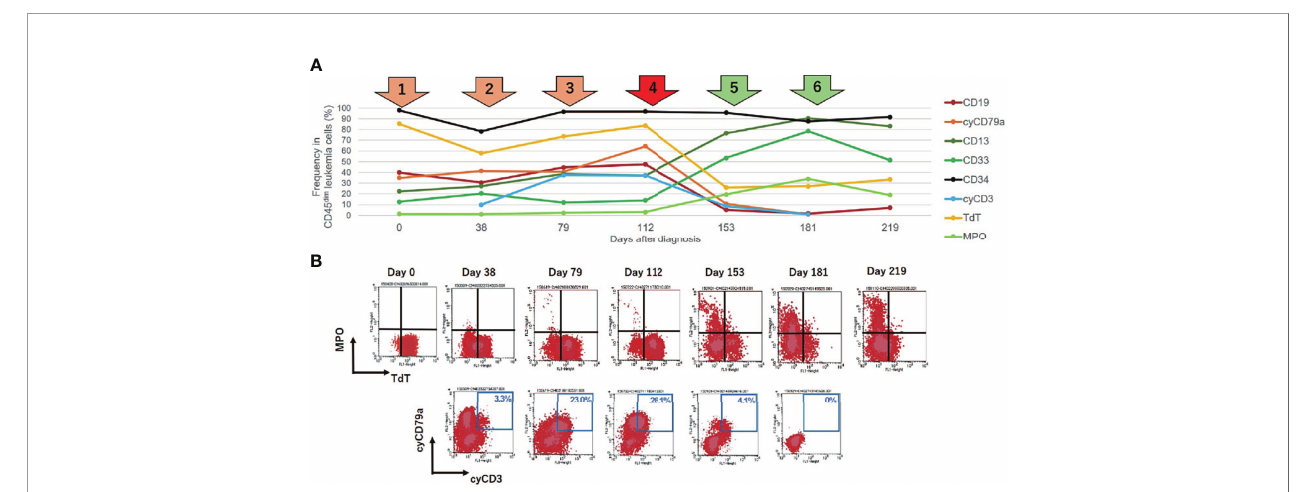
FIGURE 2 | Changes in leukemia cell immunophenotypes in the present case. Flow cytometric analysis revealed that leukemia blast cells in this case evolved immunophenotypically during sequential intensive chemotherapy. The analyzed leukemia cells were taken from bone marrow samples, with the exception of days 181 and 219 (when samples were taken from peripheral blood). (A) Changes in the frequency of immunophenotypic markers in CD45 dim leukemia cells. The arrows above the graph represent each chemotherapy regimen. Orange and red arrows represent intensive chemotherapy regimens for B-cell acute lymphoblastic leukemia (B-ALL), whereas green arrows indicate treatment regimens for acute myeloid leukemia (AML). After clofarabine monotherapy, administered as a fourth chemotherapy regimen (red arrow), a dynamic change in lineage marker expression was observed. (B) Changes in the immunophenotypic plot of CD45 dim leukemia cells (upper row, myeloid [myeloperoxidase, MPO] vs. lymphoid [TdT]; bottom row, B-lymphoid [cyCD79a] vs. T-lymphoid